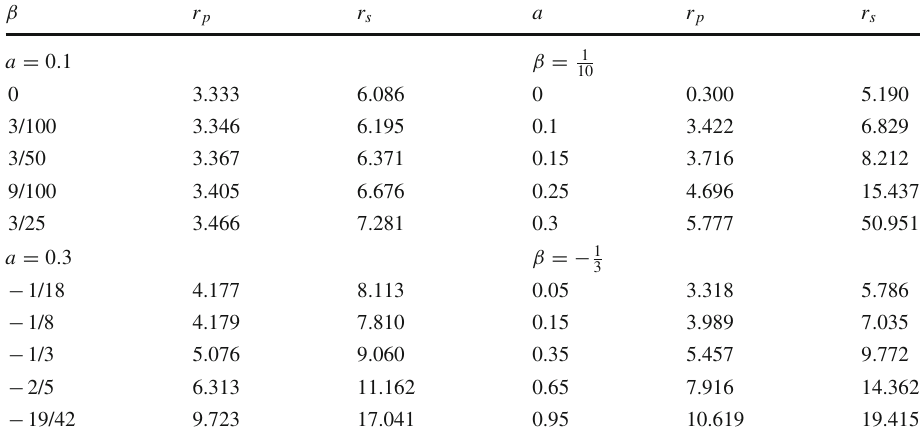
Table 1 The photon sphere and shadow radii with M =